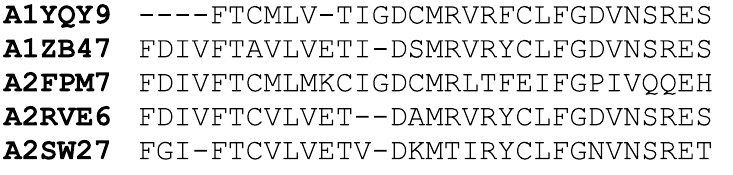
Fig 1. Example of MSA for a given reference structure ’ s